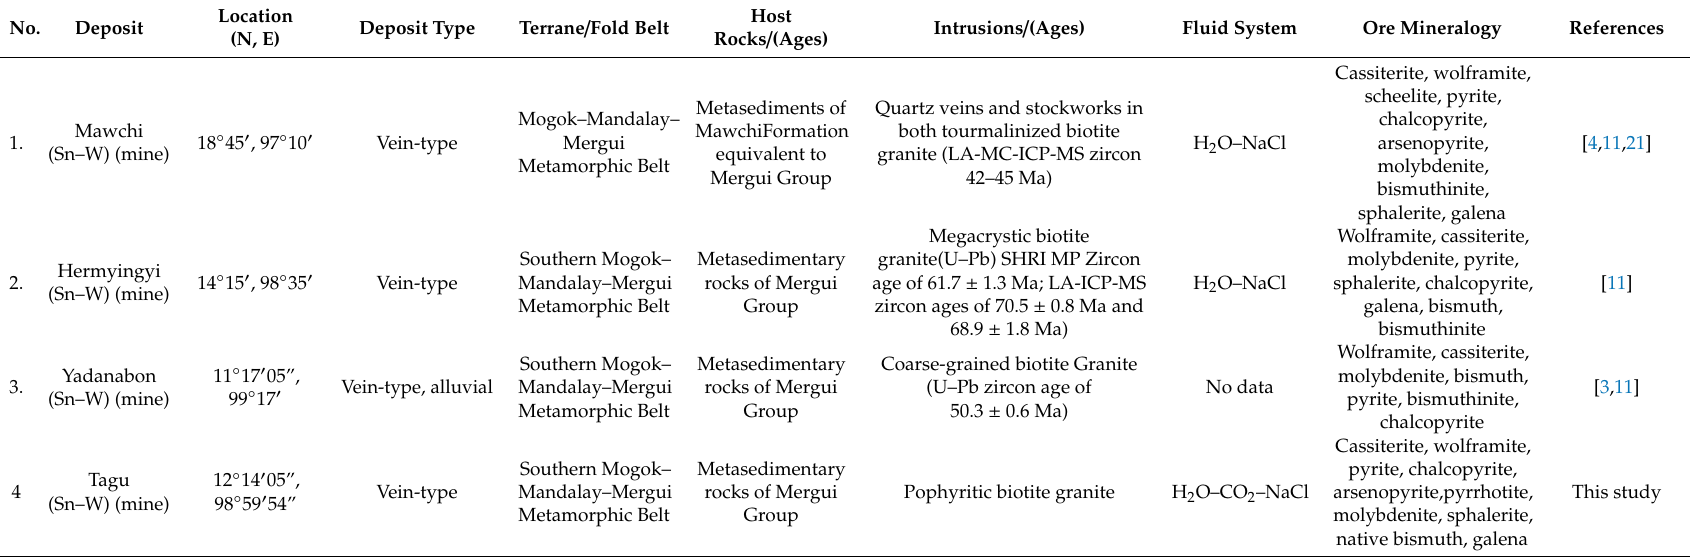
Table 3. Comparison of most important W–Sn deposits in southern